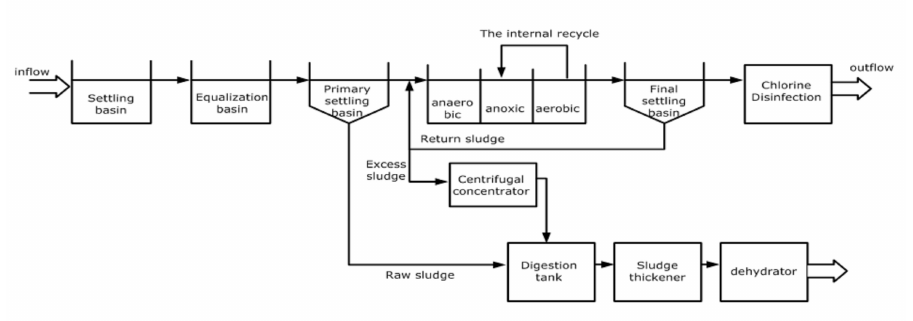
Figure 1. The process flowchart of the wastewater treatment plants in city